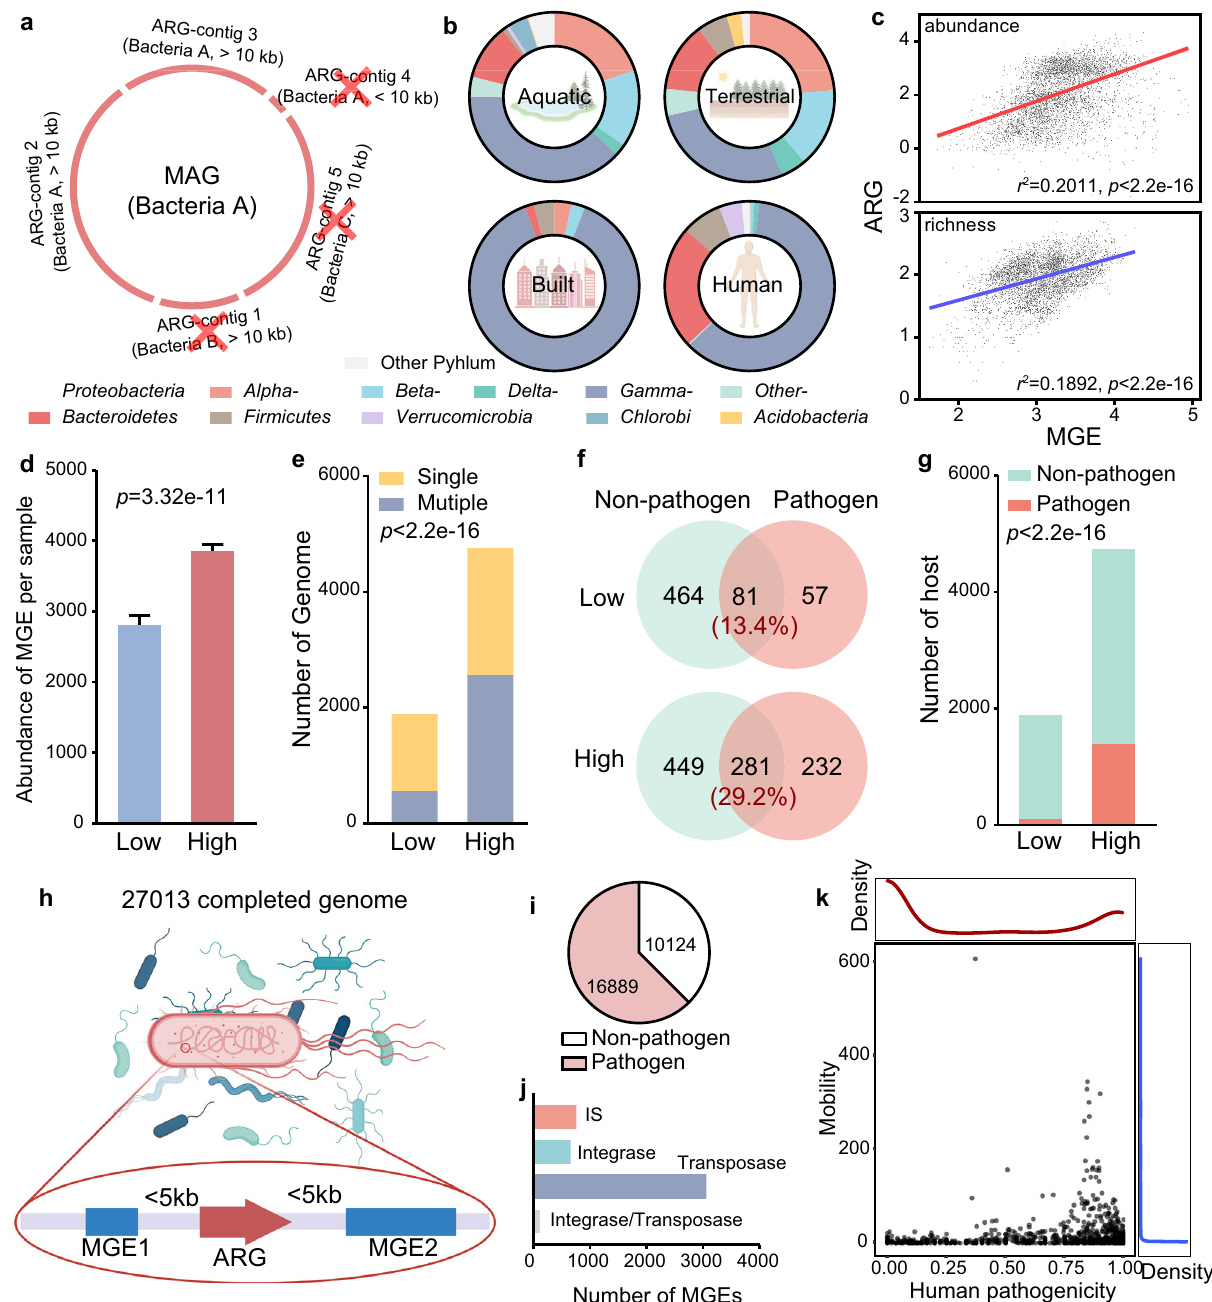
Fig. 2 Human pathogenicity and mobility of ARGs. a The host of ARGs were determined by only considering ARGs in contigs longer than 10 kb and making sure that the taxonomic af fi liation of those ARG-containing contigs agree with the overall taxonomy of the MAG. b Composition of antibiotic resistance host at the phylum level (and classes in Proteobacteria ) showed the different distributions of ARG hosts in four main habitats. c MGEs exhibited a signi fi cantly positive correlation with ARGs in abundance and richness. Each point represents one sample ( n = 4572 samples). The value of abundance and number of ARGs were showed in log10. Result of linear regression are shown as r 2 and p value, evaluated by F -statistic (one-sided). d Abundance of MGEs in high-intensity human activities areas were signi fi cantly higher than in low-intensity human activities areas. n = 1643 and 2309 biologically independent samples for Low- and High-group, respectively. Signi fi cance between two groups was evaluated by two-tailed Welch ’ s t -test. Data were showed as mean ± standard error of mean (SEM). e Number of genomes containing multiple ARGs increased in high-intensity human activities areas, compared to the low-intensity human activities areas (Fisher ’ s exact test, one-sided). f Shared ARGs in pathogens or non-pathogen increased in high-intensity human activities areas, compared to low. The percentage of shared ARGs in the two areas are shown. g Pathogenic hosts of ARGs increased in